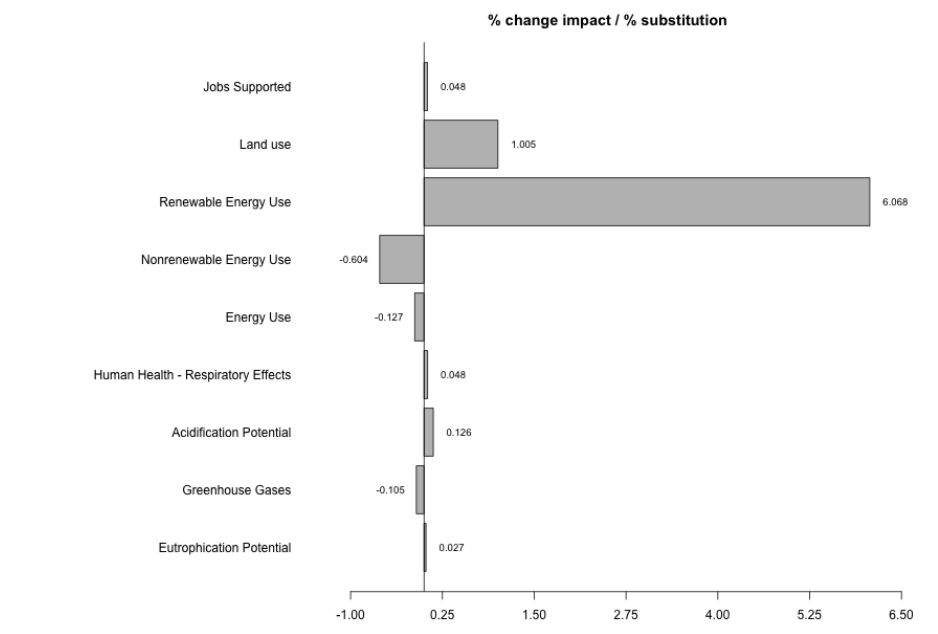
Figure 2. Percent change in impacts per percent level of new product